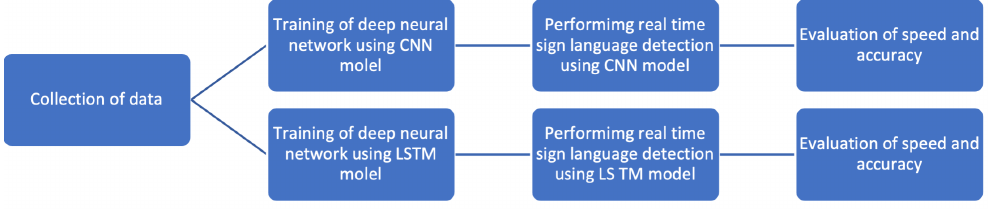
Figure 2. Conceptual